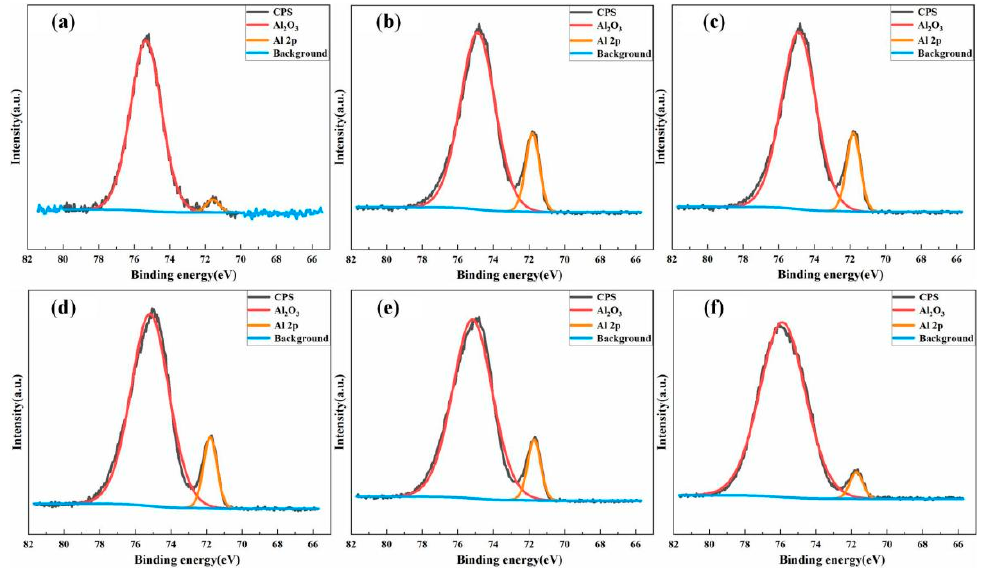
Figure 3. Detailed Al 2p X-ray photoelectron spectroscopy. ( a ) untreated and laser-cleaned with ( b ) 3.5 J/cm 2 ; ( c ) 17.5 J/cm 2 ; ( d ) 26.25 J/cm 2 ; ( e ) 35 J/cm 2 ; ( f ) 52.5 J/cm 2 [33].